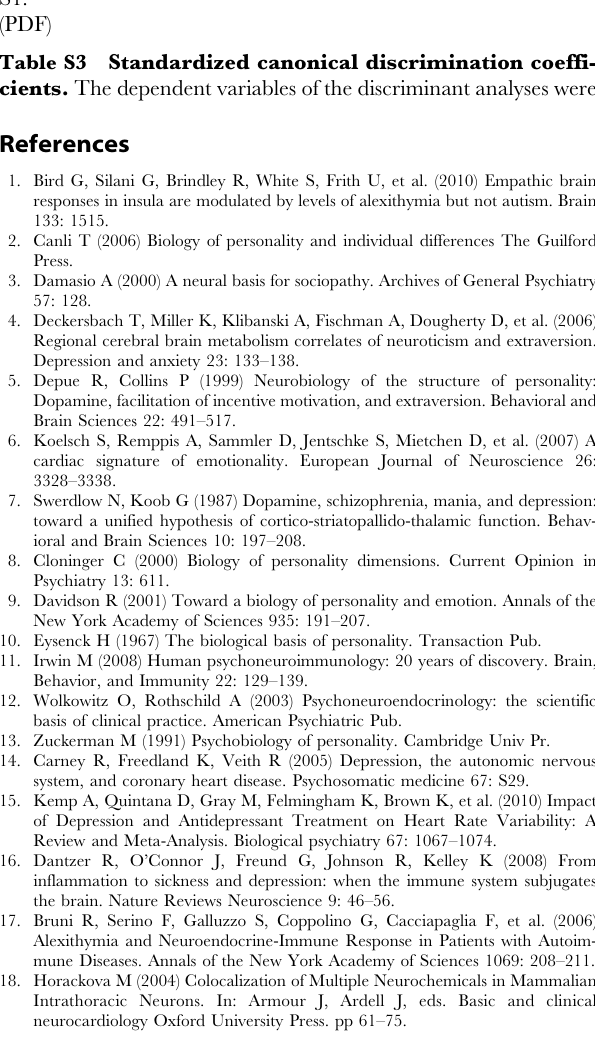
Table S2 Regression models. (a) Model resulting from stepwise linear regressions with absolute values of all ECG amplitude waves (see Methods), as well as body height, weight, and BMI, as independent (predictor) variables, and agreeableness (standard scores) as dependent variable. Note that this regression model included body height as a predictor variable (due to a significant correlation between body height and agreeableness in our sample, see main text). To remove this contribution of body height to the explanation of agreeableness with ECG waves, the residuals of a linear regression with agreeableness as dependent variable, and body height as independent variable were used for a stepwise regression with the ECG amplitude values (as well as height, weight, and BMI) as independent variables. (b) shows the model of resulting from this regression (in which the explanation of agreeableness by means of ECG amplitude values is corrected for body height). (c) Model resulting from stepwise linear regressions with absolute values of all ECG amplitude waves (see Methods), as well as body height, weight, and BMI, as independent (predictor) variables, and positive emotion (T-scores) as dependent variable. Abbrevations of ECG waves as in Table